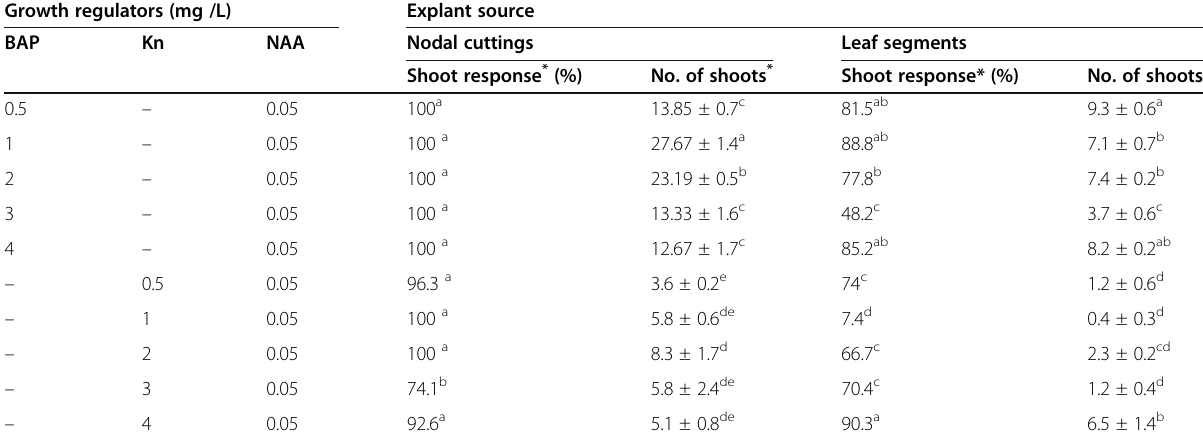
Table 2 Effect of different cytokinin (BAP and Kn) concentrations in combination with 0.05 mg/L NAA on shoot multiplication from different explant sources of A. pubescens Growth regulators (mg /L)